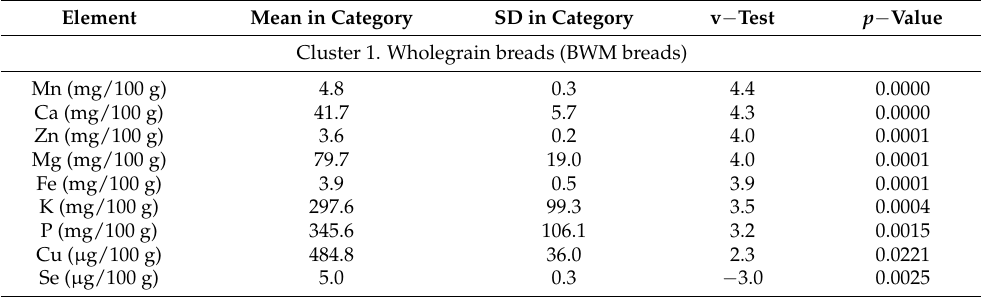
Table 3. Results for the v-test. Significant elements for characterization of bread clusters.